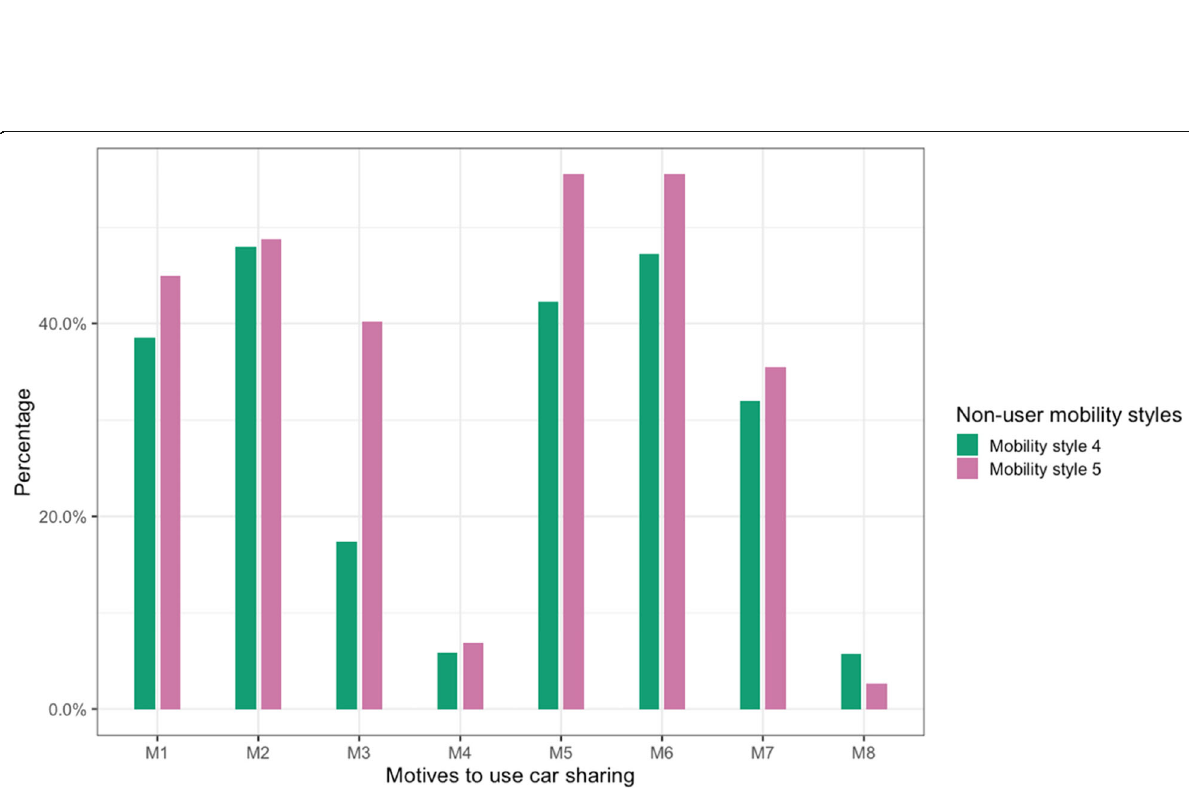
Fig. 2 Percentage of motives selected by user mobility styles, addressed by the question: In your opinion, which of the following motives would be incentives for you to use car